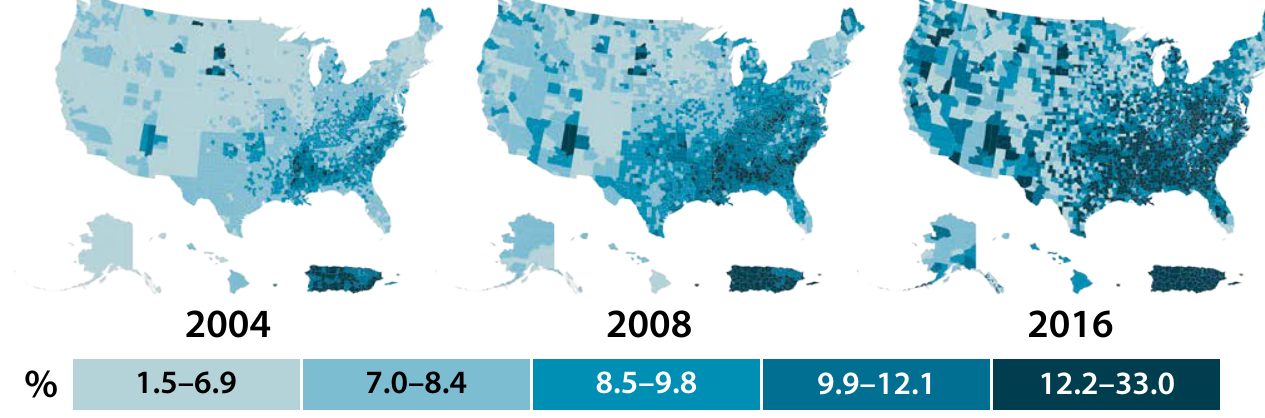
Figure 3. Age-adjusted, county-level prevalence of diagnosed diabetes among adults aged 20 years or older, United States, 2004, 2008, and